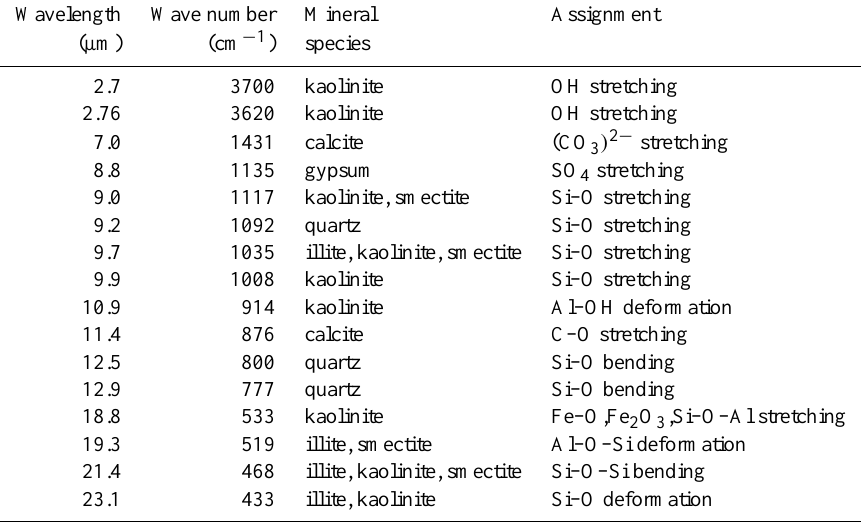
Table 3. Position of the main detected dust infrared band peaks with associated mineral species and transition